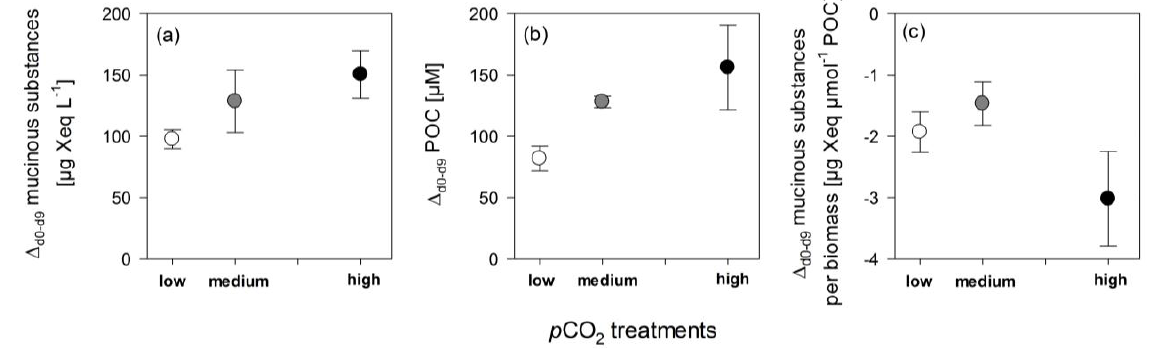
Fig. 2. Comparison of biomass production and accumulation of mucinous substances during the growth phase (day 0 to day 9). Symbols display the mean of three replicates with standard deviation.